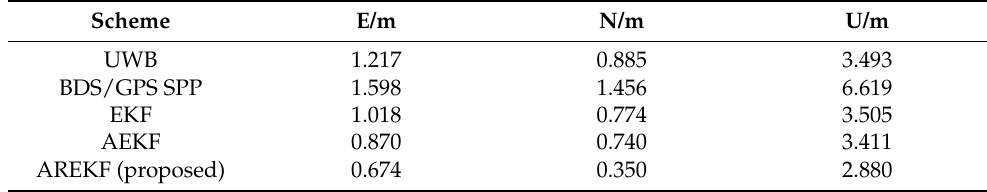
Table 1. RMS for different